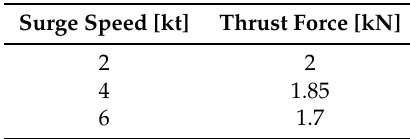
Table 1. Data obtained from manufacturer for an operating point of a single AJ245 waterjet unit. Surge Speed